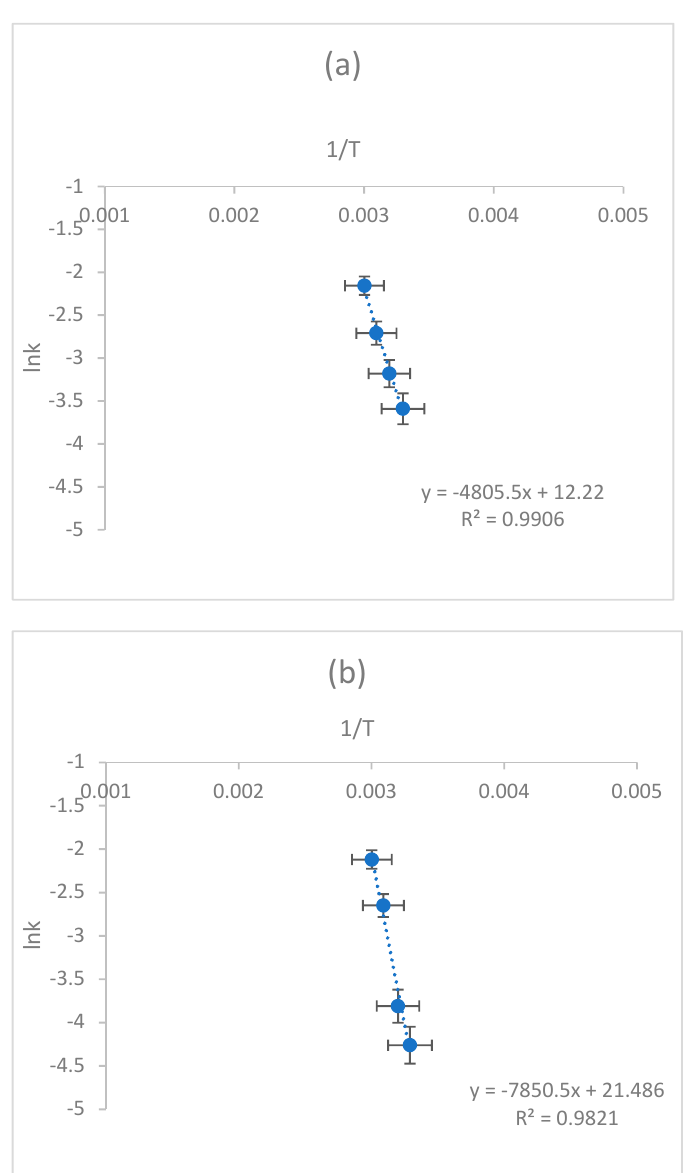
Figure 8. The graph of 1/ T versus lnk. ( a ) DMAB graph and ( b ) LiBH 4 graph .